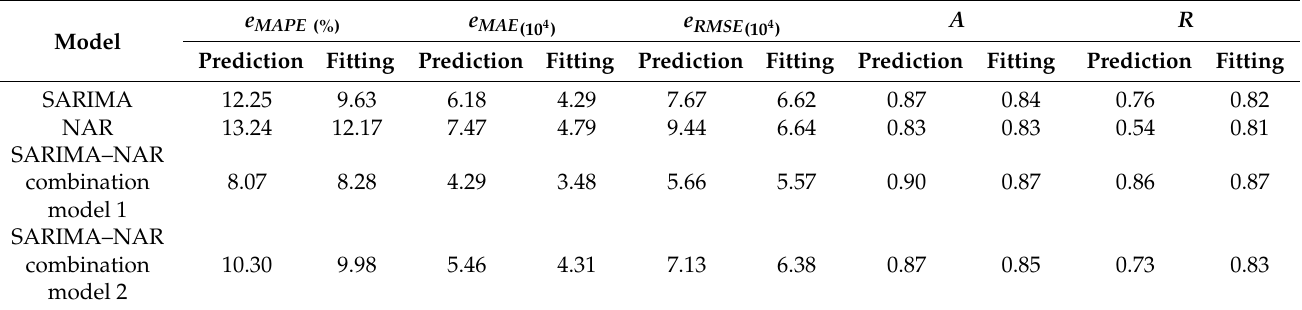
Table 5. Model prediction and fitting situation under the influence of the epidemic.